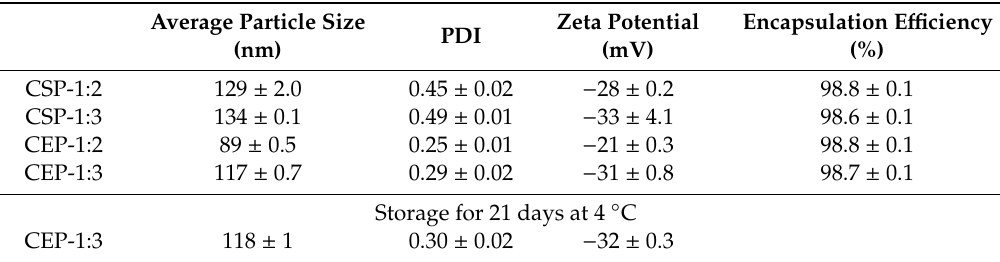
Table 1. Average particle size, polydispersity index (PDI), zeta potential, and encapsulation e ffi ciency of chrysin-loaded